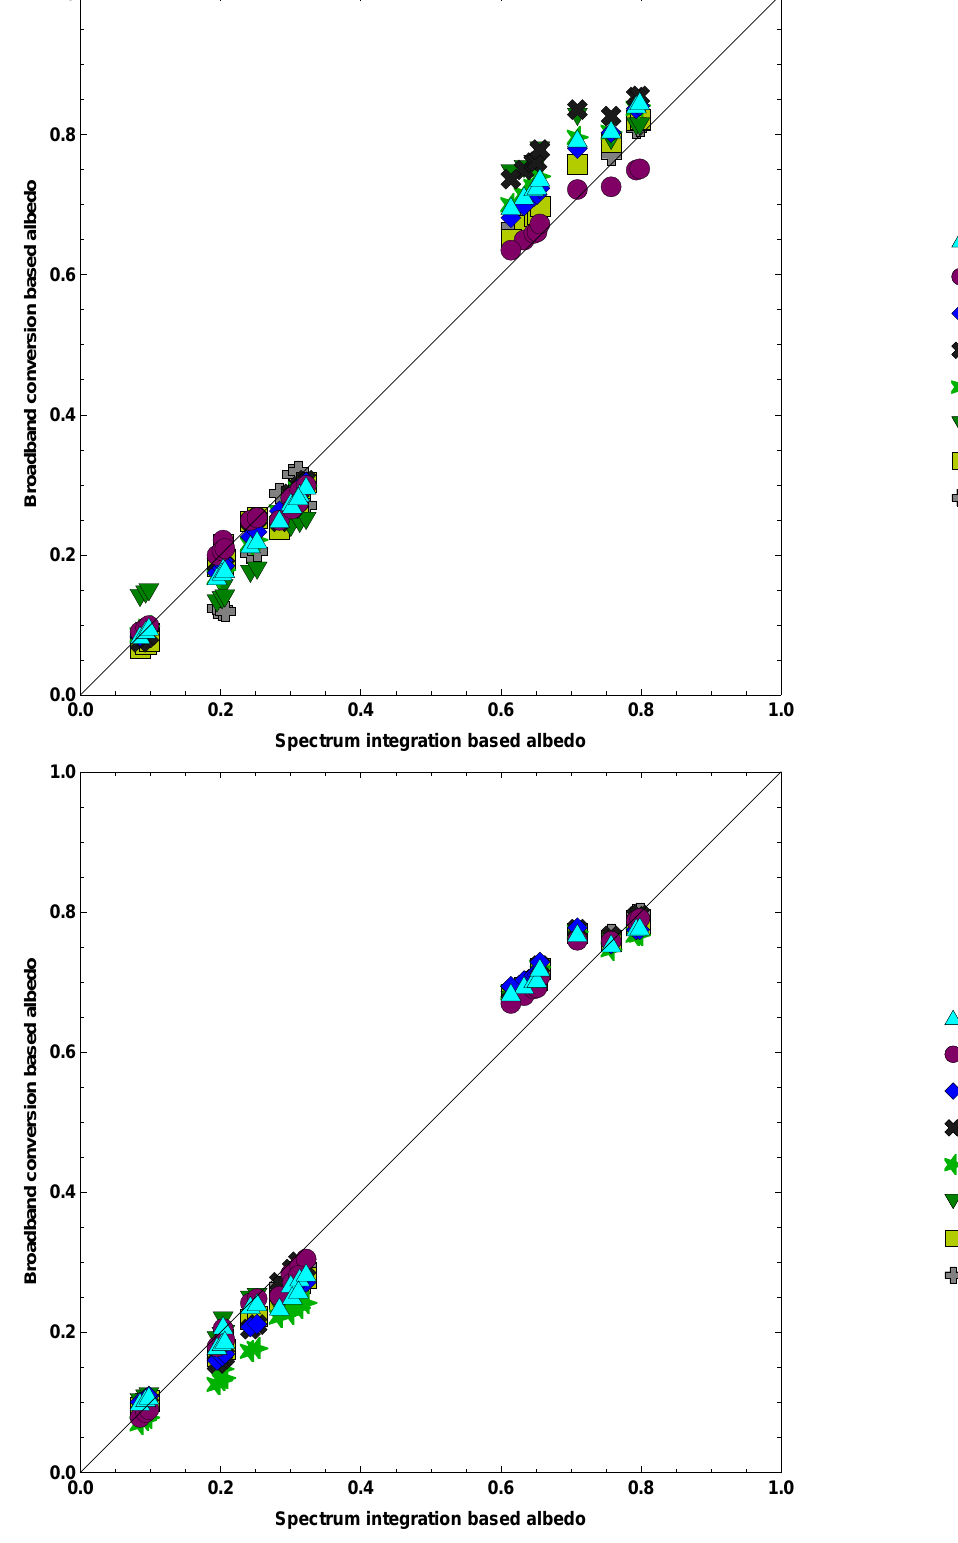
Figure 11. The albedo calculated using broadband conversion methods versus the integrated measured BRF spectrum for various targets and the sun zenith angle values. Top: The conversion methods developed by Liang [25] are colour-coded as shown. Bottom: The conversion methods by vanLeeuwen and Roujean [26] are colour-coded as